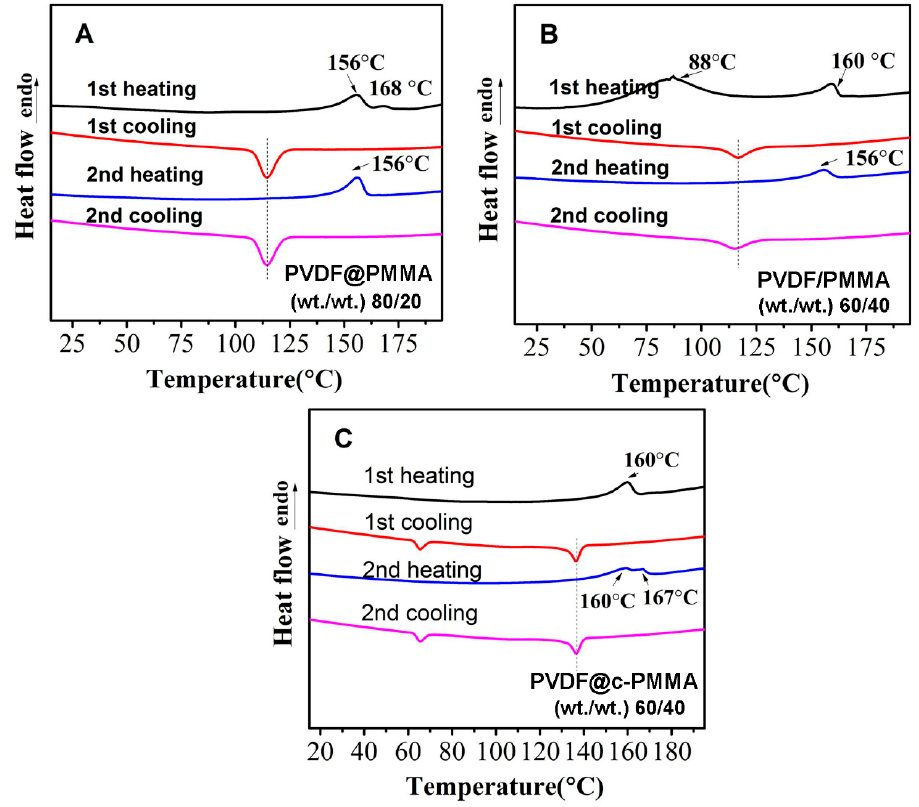
Figure 3. Heating–cooling cycle curves for selected PMMA contents in different latex blends: ( A ) PVDF@PMMA 80/20; ( B ) PVDF/PMMA 60/40; and ( C ) PVDF@c–PMMA 60/40.